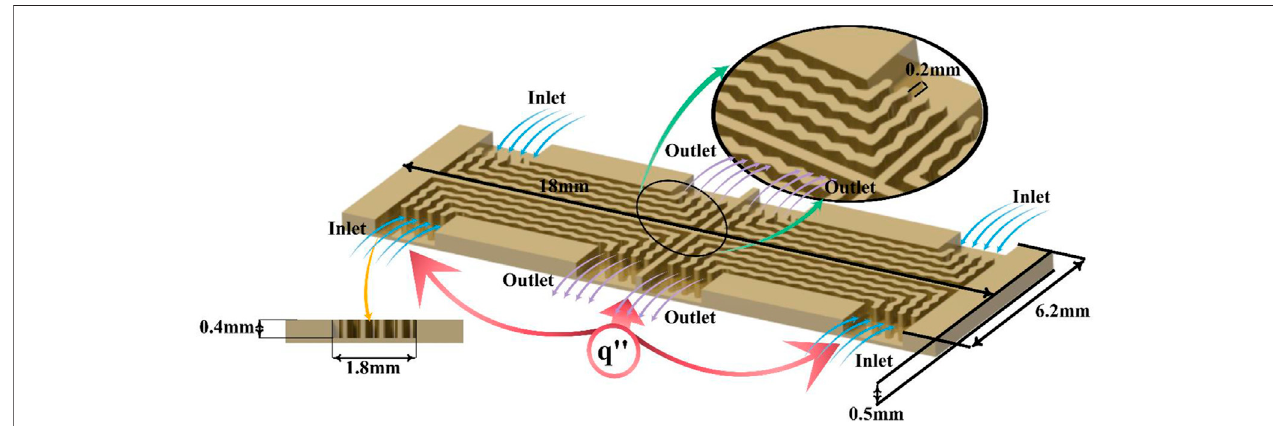
FIGURE 1 | Details of the H-S geometry.